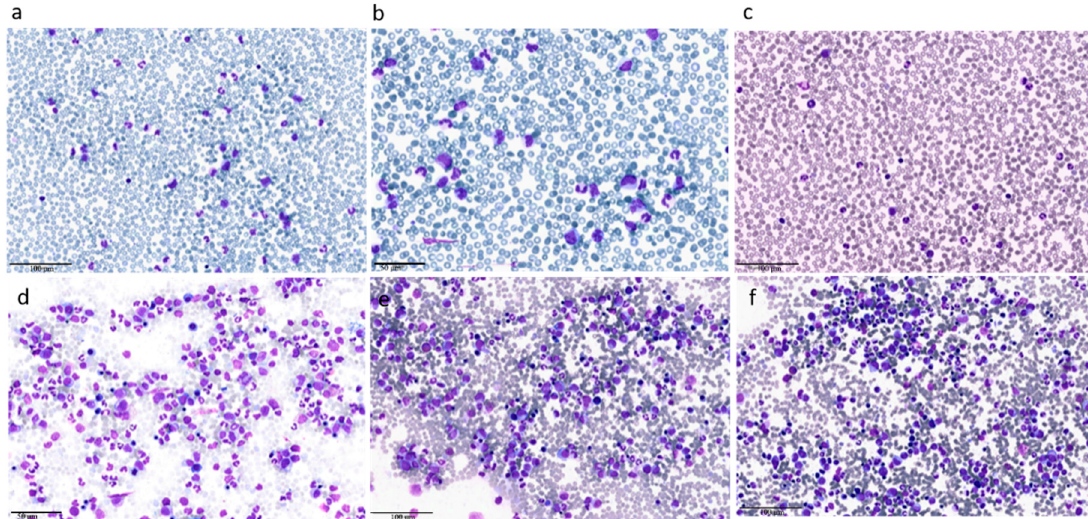
Figure 1. Peripheral blood (PB) and bone marrow (BM) smears of patient 1. Panels a - b - c : the PB shows hyperleukocytosis with neutrophil precursors (promyelocytes, myelocytes, and metamyelocytes) representing ≥ 10% of the leukocytes, with monocytes < 10% and rare blasts. The neutrophils show pseudo-Pelger-Huet nuclear abnormalities and hypogranulated cytoplasm. Panels d - e - f : the BM is hypercellular due to an increase of neutrophils and their precursors. The myeloid/erithroid ratio is > 10:1 due to myeloid hyperplasia. Of note, the myeloid lineage shows evident signs of dysplasia similar to those present in the PB. Moreover, the megakaryocytes show signs of dysplasia with micro-megakaryocyte and cells with hypolobated nuclei.